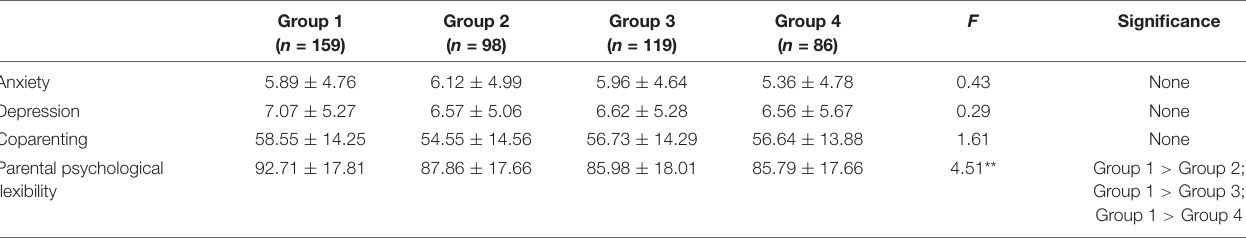
TABLE 2 | Comparisons in main study variables among parents with child(ren) at different stages.